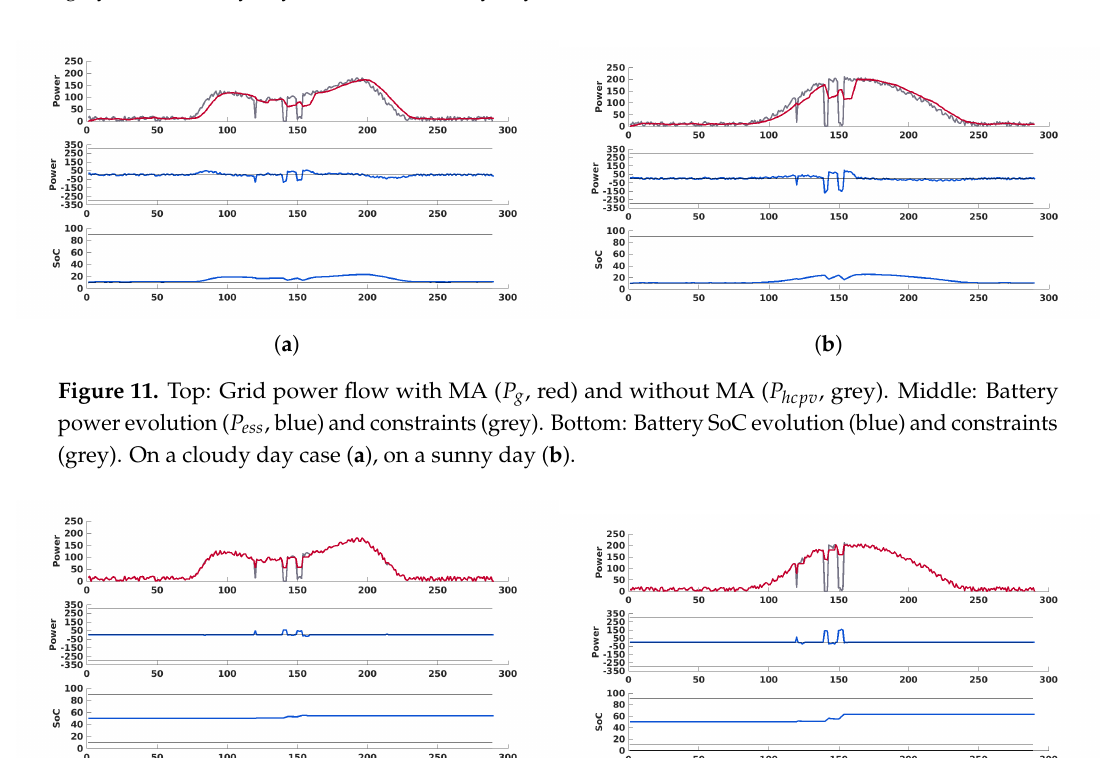
Figure 10. Top: Grid power flow with RC ( P g ,red) and without RC ( P hcpv , grey). Middle: Battery power evolution ( P ess , blue) and constraints (grey). Bottom: Battery SoC evolution (blue) and constraints (grey). On a cloudy day case ( a ), on a sunny day ( b ).